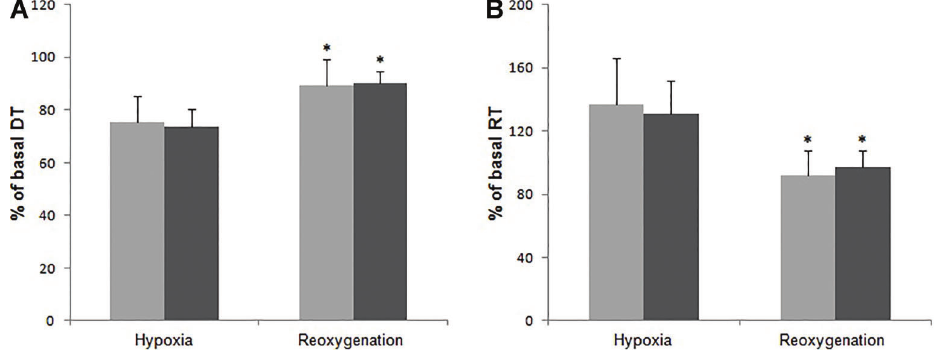
Figure 2. In fl uence of hypoxia (60 min) and reoxygenation (30 min) on ( A ) developed tension (DT – g/mm 2 ) and ( B ) resting tension (RT – g/mm 2 ) of isolated papillary muscle from aortic stenosis (AoS, n=18; dark gray columns) and control groups (Sham, n=16; light gray columns). Data are reported as means ± SD. *P o 0.001, vs hypoxia (multivariate analysis for repeated measures model in independent groups, complemented with Bonferroni ’ s multiple comparison